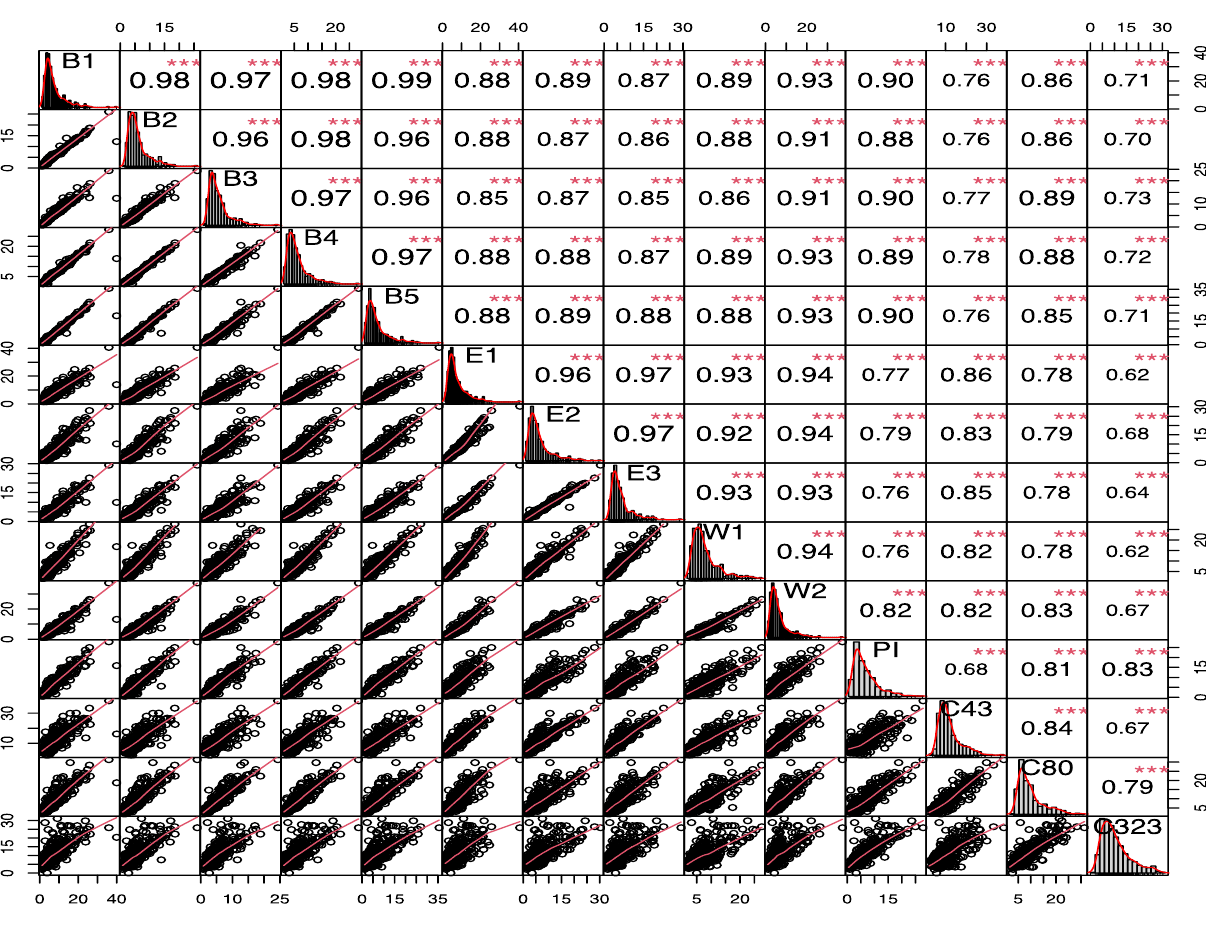
Figure 6. Spearman’s correlation plot with histograms, regression lines, and density functions. Correlation is significant at the 0.01 level *** (2-tailed). N = 352 to 396 for all pairs. Statistical significance was set at 0.01 level (represented by **). Stronger relationships